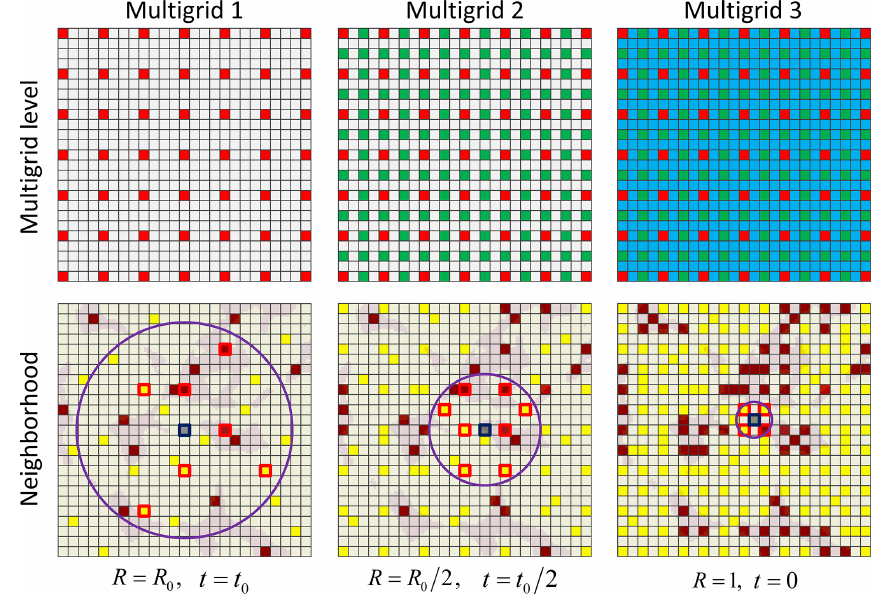
Figure 3. An example of multiple grids and the corresponding neighborhoods, search radius R and distance threshold t